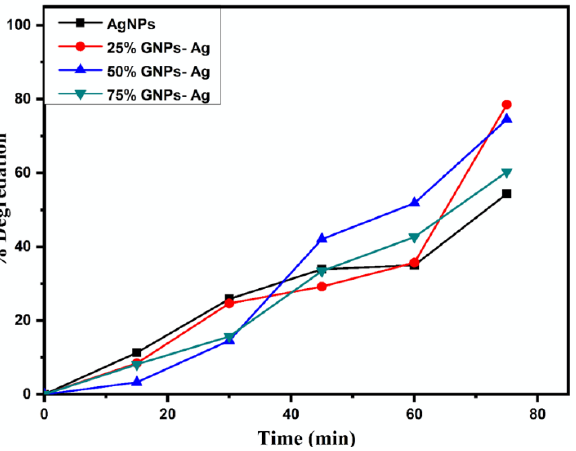
Figure 13. % Degradation of MB under visible light irradiation with (Ag) 1 − x (GNPs) x . Here, Ct is referred to as concentration at various intervals of time, Co means the initial concentration of aqueous suspension of MB, and Co and Ct are evaluated by means of Beer Lambert’s law. The absorption of MB depicts a reducing trend with the rise in exposure time in the light. Pseudo-first-order kinetics is applied for the photocatalytic activity of AgNPs and Ag/Graphene nanocomposites explicitly utilizing the expression below. ln(Co/C) = kt The rate constants recorded by linear fitting the data are 0.7358 min − 1 , 0.9202 min − 1 , 0.9063 min − 1 and 0.8873 min − 1 for silver NPs, 25% GNPs-Ag, 50% GNPs-Ag and 75% GNPs-Ag nanocomposites, respectively (Figure 14). The constant rate variations are associ- ated with the addition of graphene in the